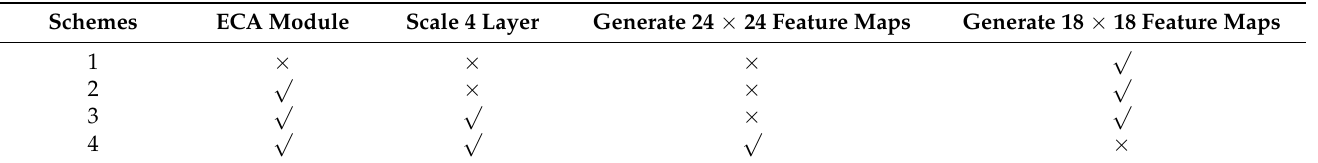
Table 5. The improved schemes.